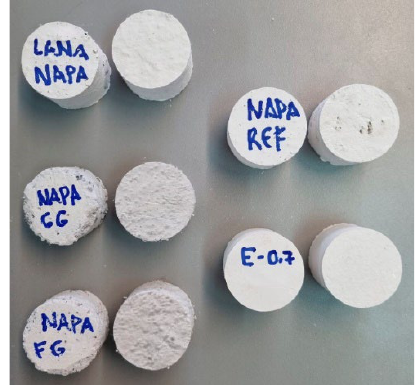
Figure 11. Samples tested.